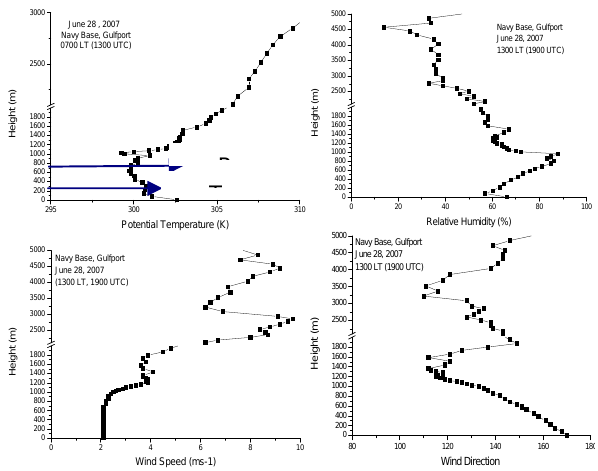
Figure 7 : Profiles of potential temperature, R.H, Wind speed and direction during sea breeze time at Sea Bee Base. Similarly the profiles at Harrison during the sea breeze time show a steep and shallow unstable layer. Greater wind shear associated with fluctuation in the wind speed profiles is noticed at 13:00 LT during the sea breeze time.